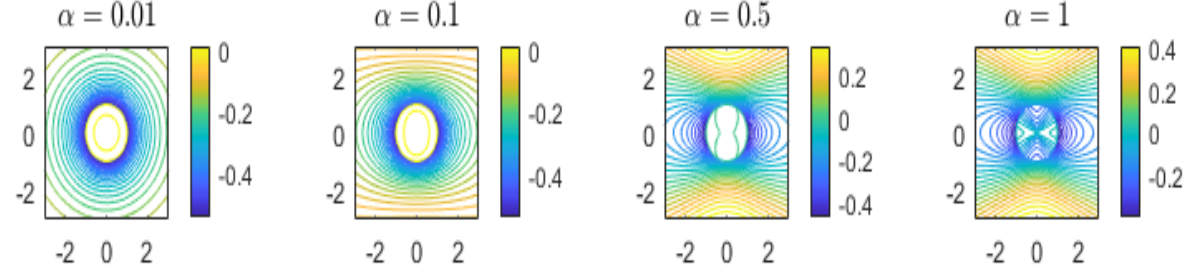
Figure 2. Streamlines at different α and ω = 1 for case 3 (unit step